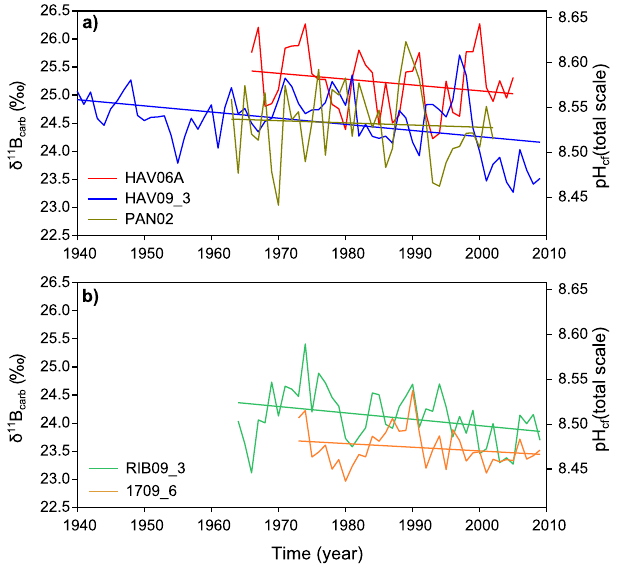
Figure 3. Annual time series and linear regressions for δ 11 B carb values and corresponding pH cf of coral cores from (a) the inner- shelf reefs of Havannah Island and Pandora Reef, and (b) the mid- shelf reefs of Rib Reef and 17-065.